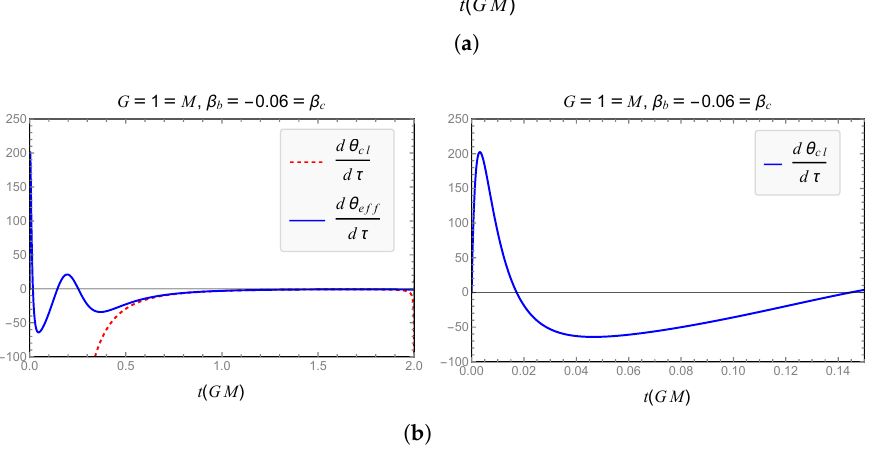
d θ ( TL ) ( TL ) GUP ( 1 ) Figure 16. θ and . ( a ) Classical vs. timelike θ in GUP model 1 as a function of the d τ GUP ( 1 ) Schwarzschild time t . ( b ) Left: Classical vs. timelike d θ Schwarzschild time t . Both the effective effective expansion θ to zero as t → 0. Right: Close up of the left figure close to t =